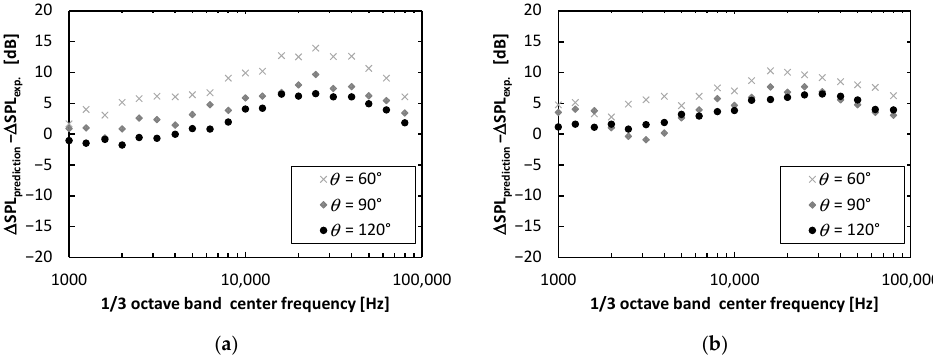
Figure 9. Results of validation tests for fan noise shielding effect: ( a ) φ = 0°, ( b ) φ = 45°.